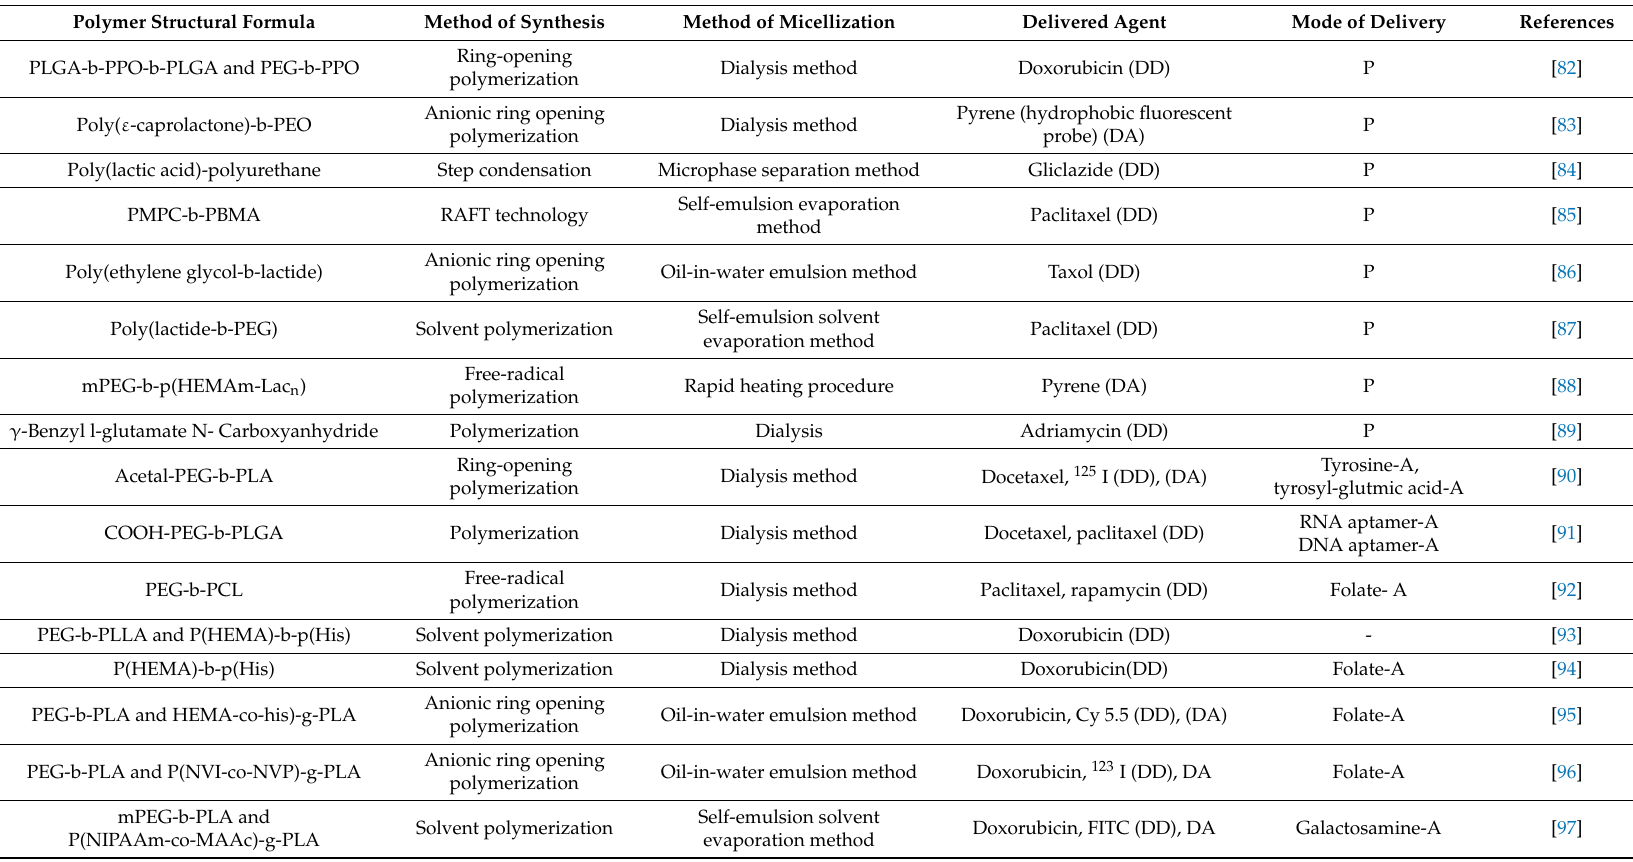
Table 3. Polymeric micellar systems employed for treatment and diagnosis (adapted from Kedar et al. [80]; Chen et al.